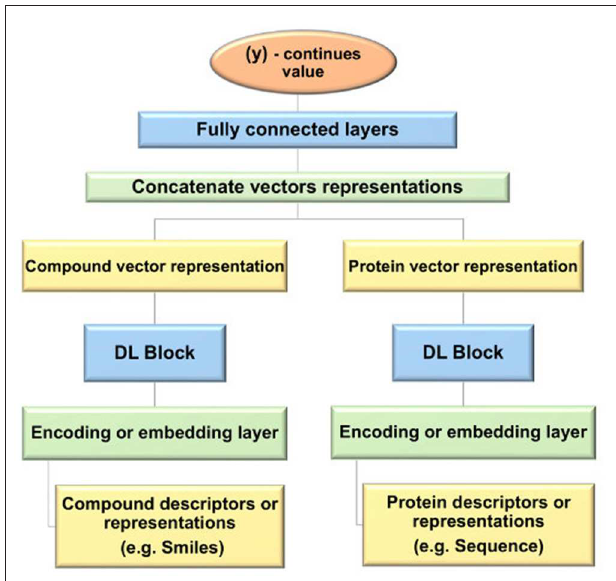
FIGURE 4 | Flowchart of the general framework of deep learning (DL) models used for drug-target binding affinity (DTBA)